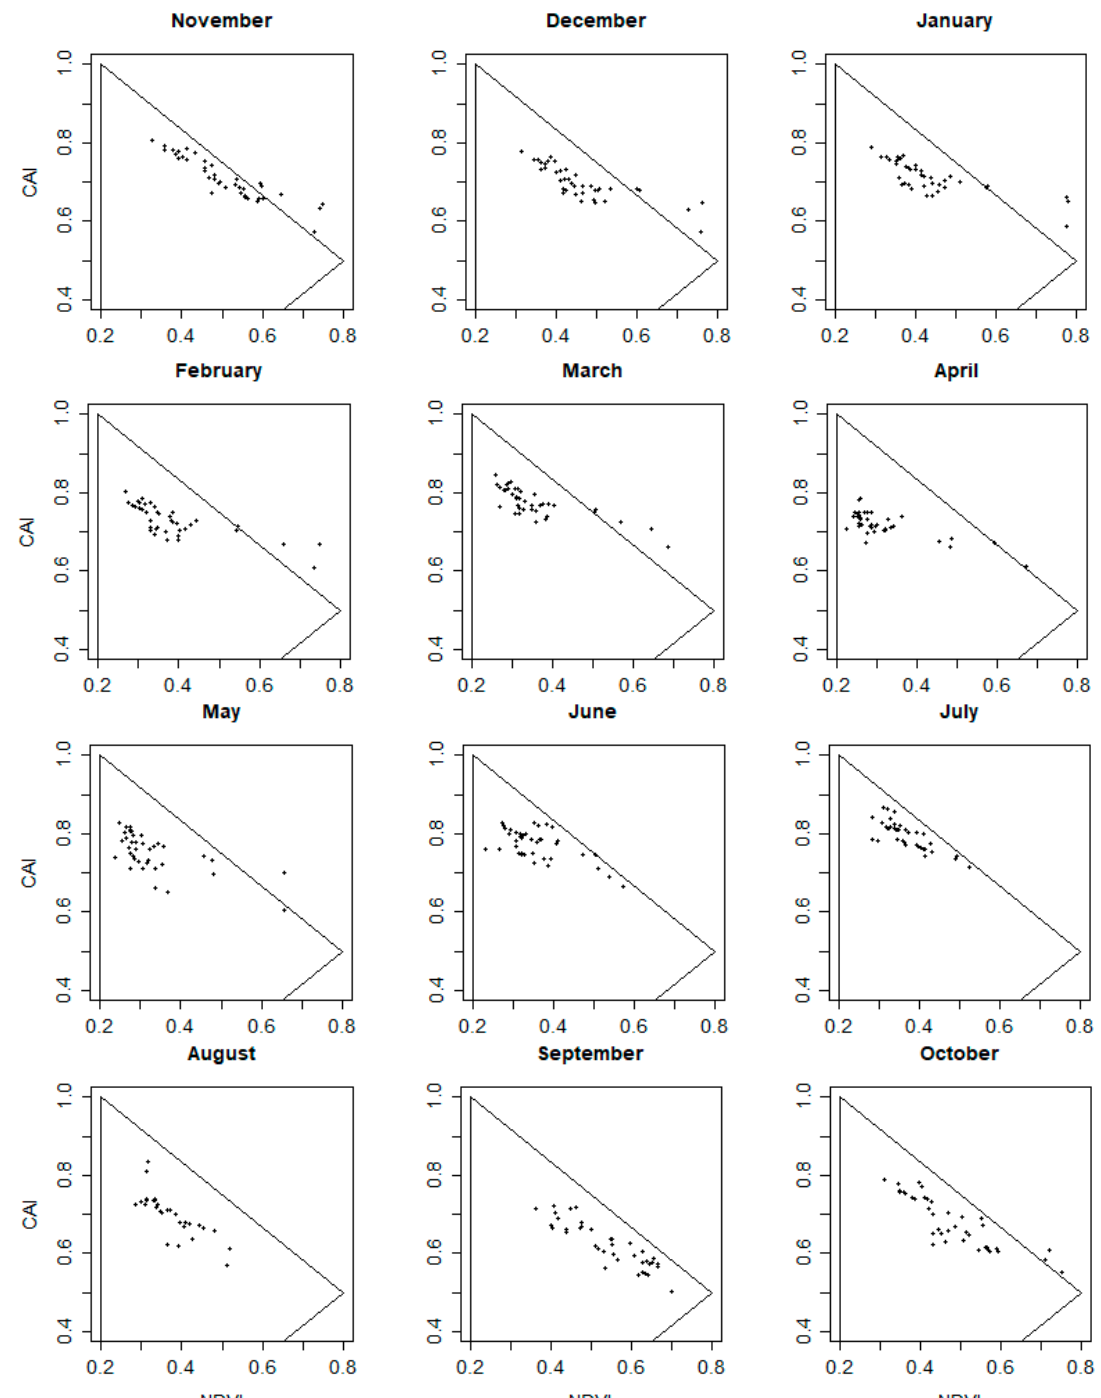
Figure A2. Location of the Ethiopian plots in the NDVI – CAI response space for every month from November 2017 until October 2018. The more the plots verge to the right corner of the triangle, the greener they are, while the upper left corner indicates that more NPV, such as dry and senescent plants, is present in the plots.